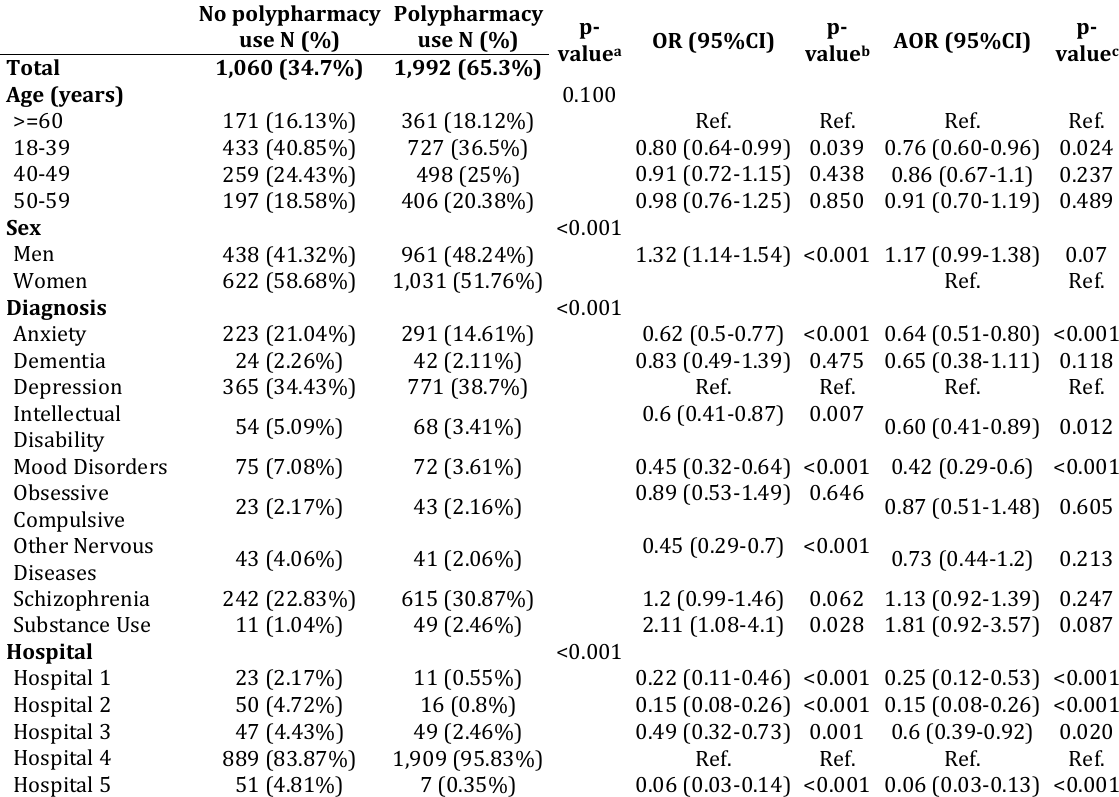
Table II Unadjusted and Adjusted odds ratios (ORs) for any psychotropic polypharmacy